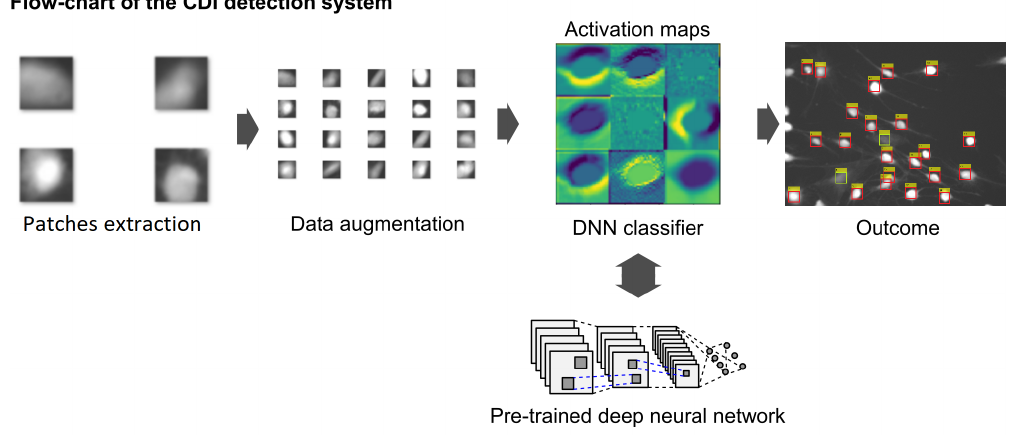
Figure 3. Algorithm stages for the classification of cells: image preprocessing consisting of nuclei and cell detection, cell separation, patch extraction, dataset augmentation, pre-trained convolutional neural network (CNN) architecture adjustment, comparison and